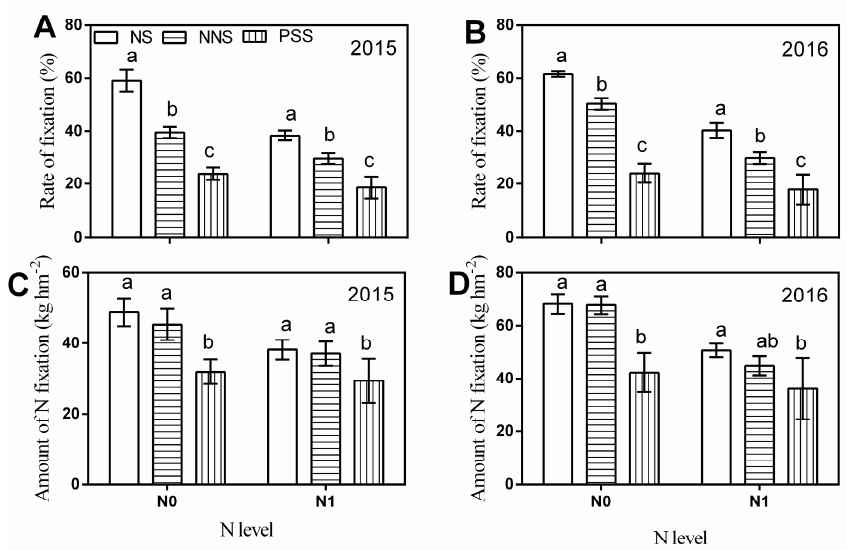
Figure A4. E ff ects of year, nitrogen levels and root separation method on %Ndfa ( A , B ) and Ndfa ( C , D ) Figure A4. Effects of year, nitrogen levels and root separation method on %Ndfa and Ndfa of of alfalfa. Di ff erent lowercase letters show significant di ff erence between root separation method under alfalfa. Different lowercase letters show significant difference between root separation method the same nitrogen levels at p ≤ under the same nitrogen levels at p ≤ 0.05.